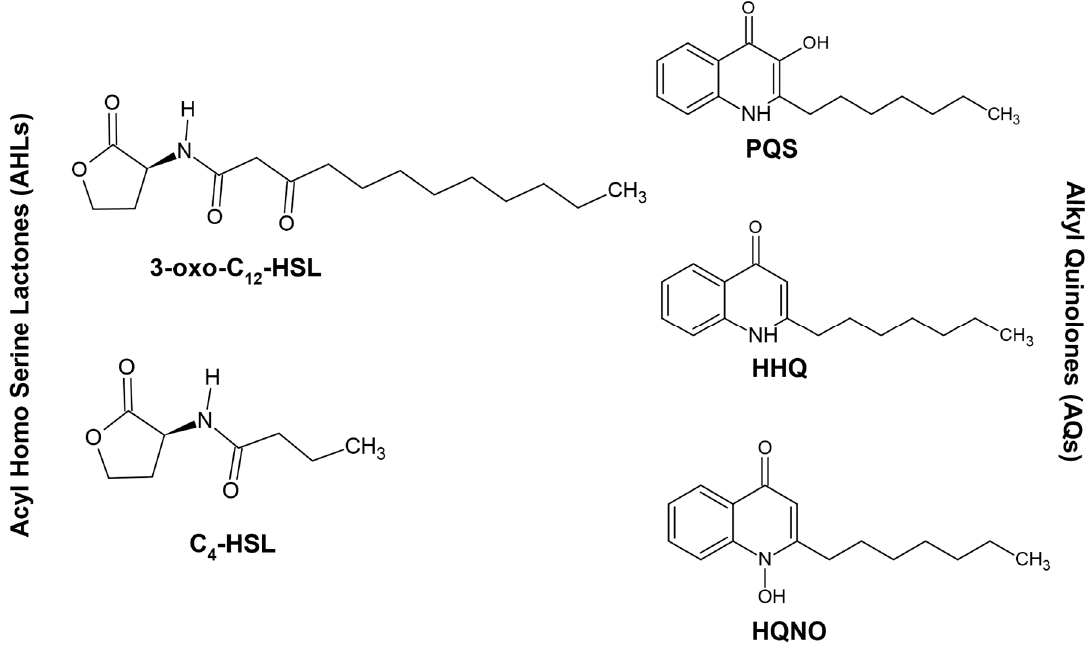
Figure 1. Structures of some common quorum signaling molecules of Pseudomonas aeruginosa .